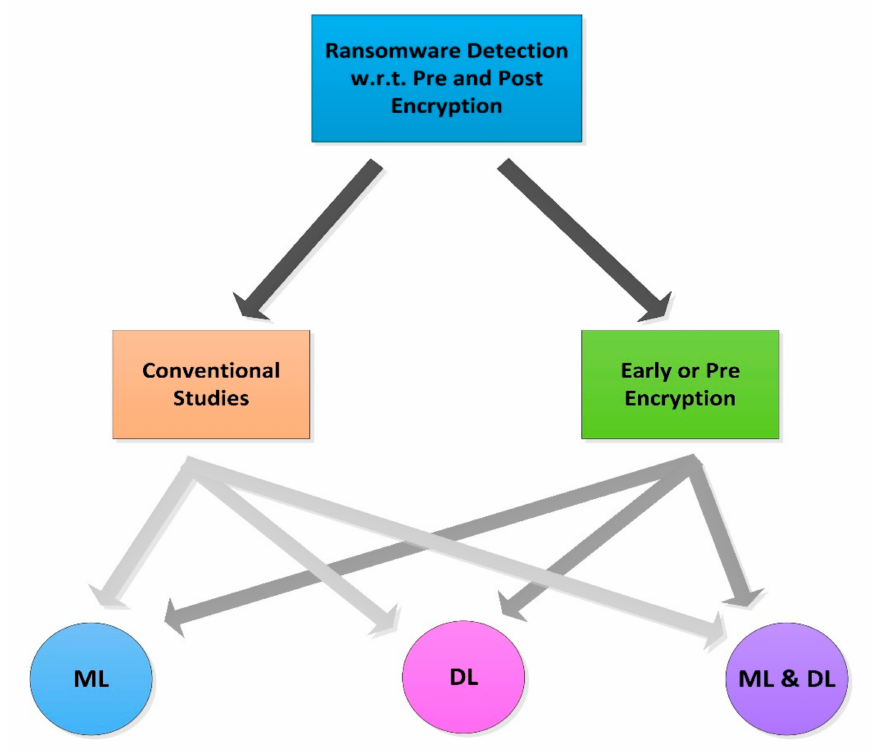
Figure 6. Overview of detection